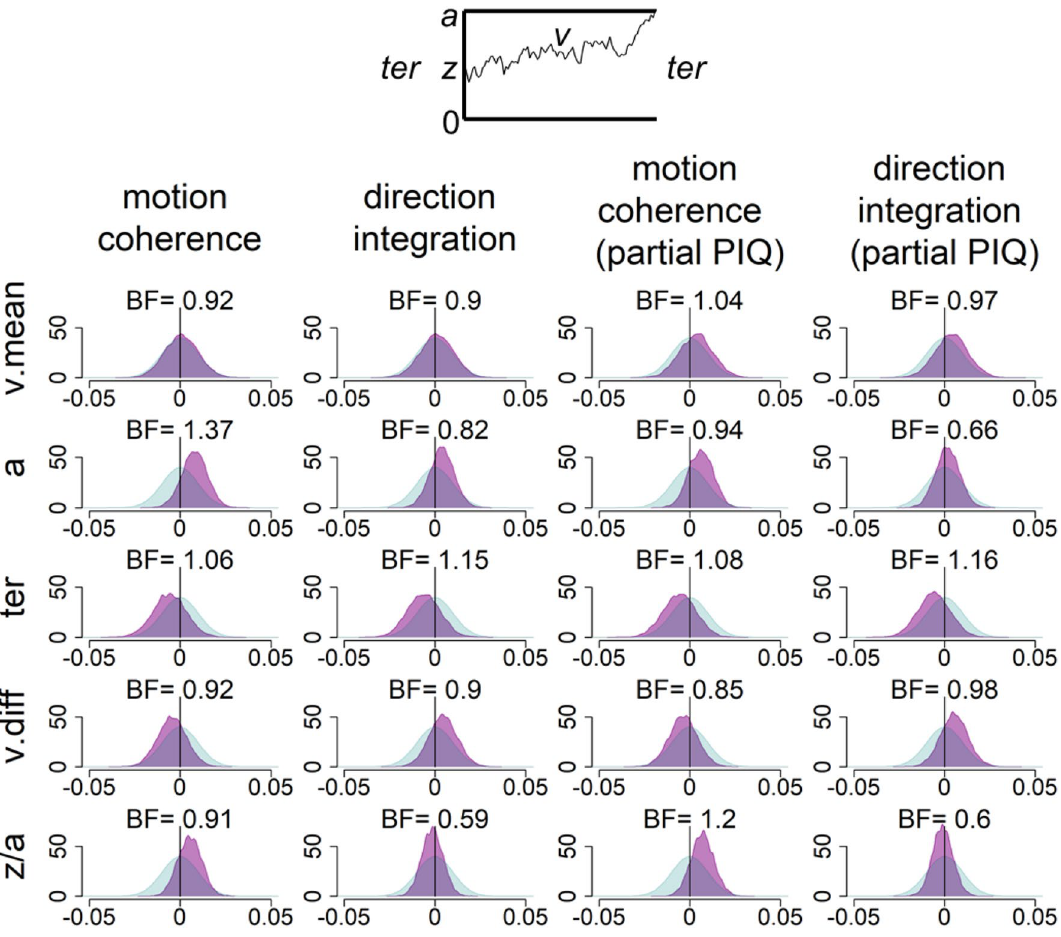
Figure 5. Prior and posterior density distributions. Prior (blue) and posterior (purple) density distributions for the group-level parameters reflecting group differences in each of the 5 model parameters (v.mean = mean drift-rate across difficulty levels; a = boundary separation; ter = non-decision time; v.diff = difference in mean drift-rate between difficulty levels; z/a = relative starting point) for each task. Inset is a schematic representation of the model parameters. Columns 1 and 2 show the results of the standard model and Columns 3 and 4 show the results of the model with performance IQ partialled out. Positive values reflect higher parameter values in the autistic group compared to the typically developing group. BF = Savage-Dickey Bayes factors in favour of the alternative hypothesis over the null hypothesis, where BF > 1 reflect more support for the alternative